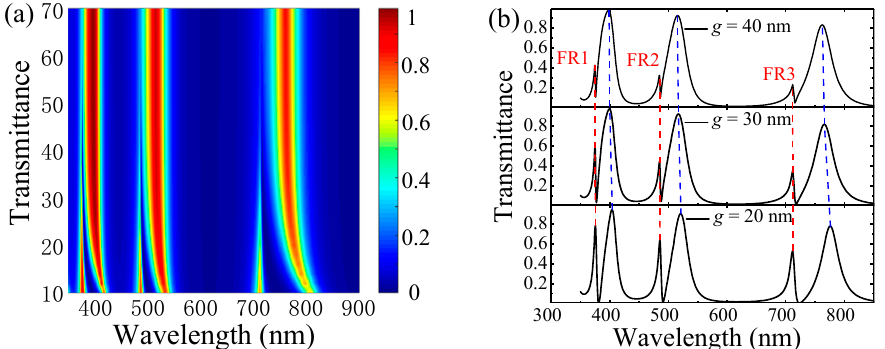
Figure 6. ( a ) Nephogram of transmission spectrums of the proposed Fano system as a function of g and wavelength with other parameters keep unchanged. ( b ) Transmission spectrums from Figure 5a with g = 10, 20, and 40 nm, respectively.